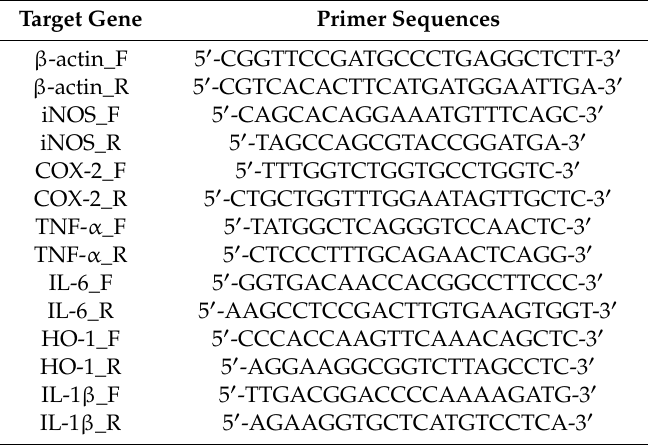
Table 1. The primers used in this